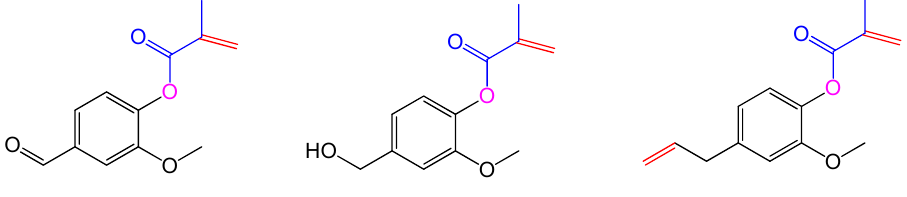
Figure 6. Novel RDs from l ignin derivatives [53–55,66].